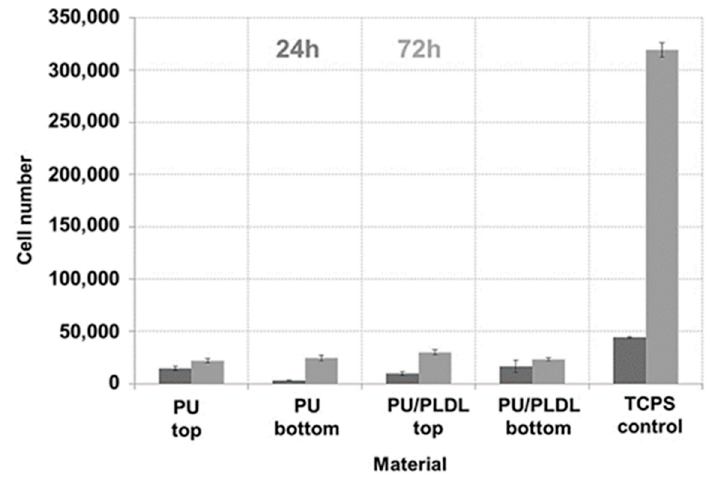
Figure 8. Effect of PU and PU/PLDL 8/2 sponges on the viability and proliferation of mice fibroblast NIH 3T3.